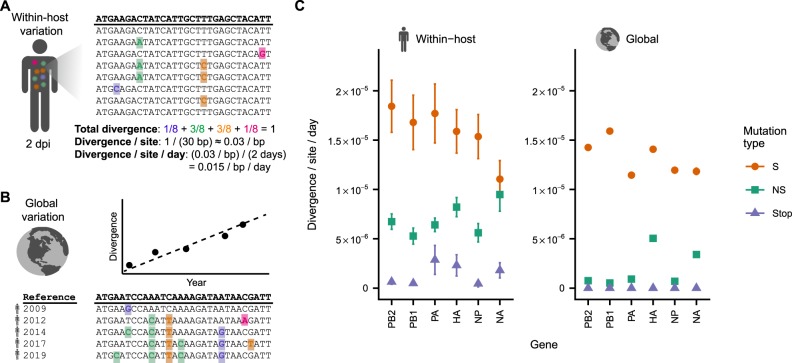
Within-host and global evolutionary rates reveal selective pressures acting on influenza virus across evolutionary scales. (A) Within-host evolutionary rates were calculated by normalizing the total divergence of each within-host viral population to the number of sites and the time elapsed since the infection began. (B) Global evolutionary rates were calculated using a molecular-clock method by performing a linear regression of divergence per site versus time. (C) Within-host and global evolutionary rates of H3N2 influenza virus at synonymous (S), nonsynonymous (NS), and stop-codon (Stop) sites. Rates of synonymous evolution are broadly similar at the within-host and global scale, but nonsynonymous mutations accumulate more rapidly within hosts than globally. Within-host rates are shown as the mean and standard error of all patient infections sequenced in the three datasets analyzed after removing outlier samples (see Section 4) (Dinis et al. 2016; Debbink et al. 2017; McCrone et al. 2018). Global rates are shown as the mean and standard error calculated through linear regression (the standard errors are smaller than the point sizes). Global rates of stop-codon evolution are zero because no stop codons are observed in patient consensus sequences.